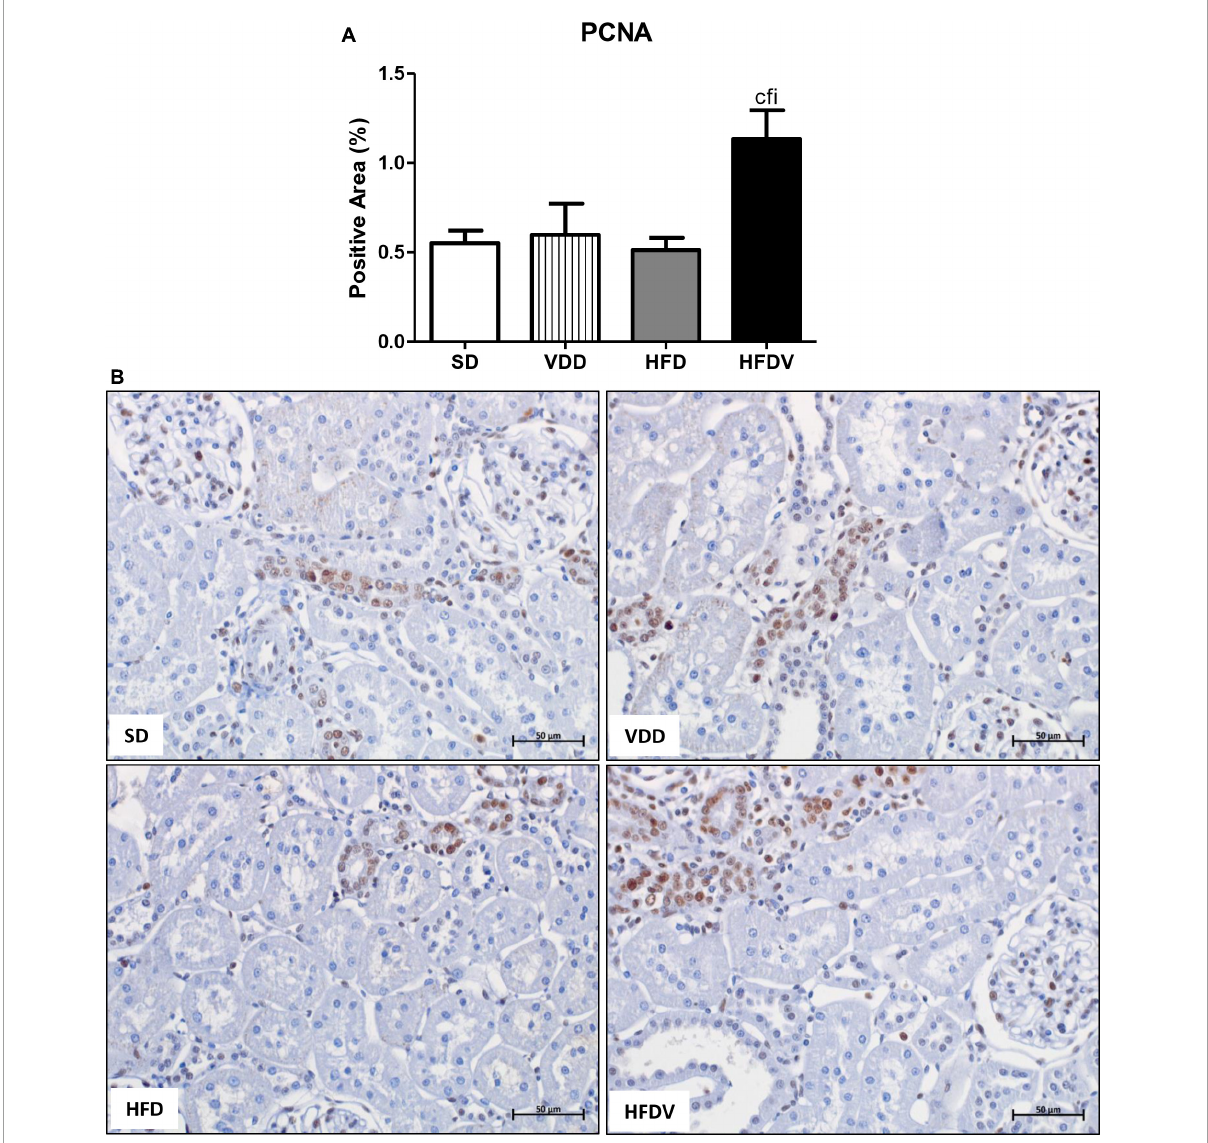
FIGURE11 Immunohistochemical analysis for proliferating cell nuclear antigen (PCNA) expression in the renal cortex evaluated after the 90-day protocol in rats submitted to renal ischemia-reperfusion insult on day 45 treated with standard diet (SD), vitamin D-free diet (VDD), high-fat diet (HFD), or high-fat vitamin D-free diet (HFDV). (A) Bar graph of PCNA expression values. (B) Representative photomicrographs of immunostaining for PCNA in the renal cortex from an SD, VDD, HFD, and HFDV rat ( × 400). Data are mean ± SEM. c p < 0.05 vs. SD; f p < 0.05 vs . VDD; i p < 0.05 vs .